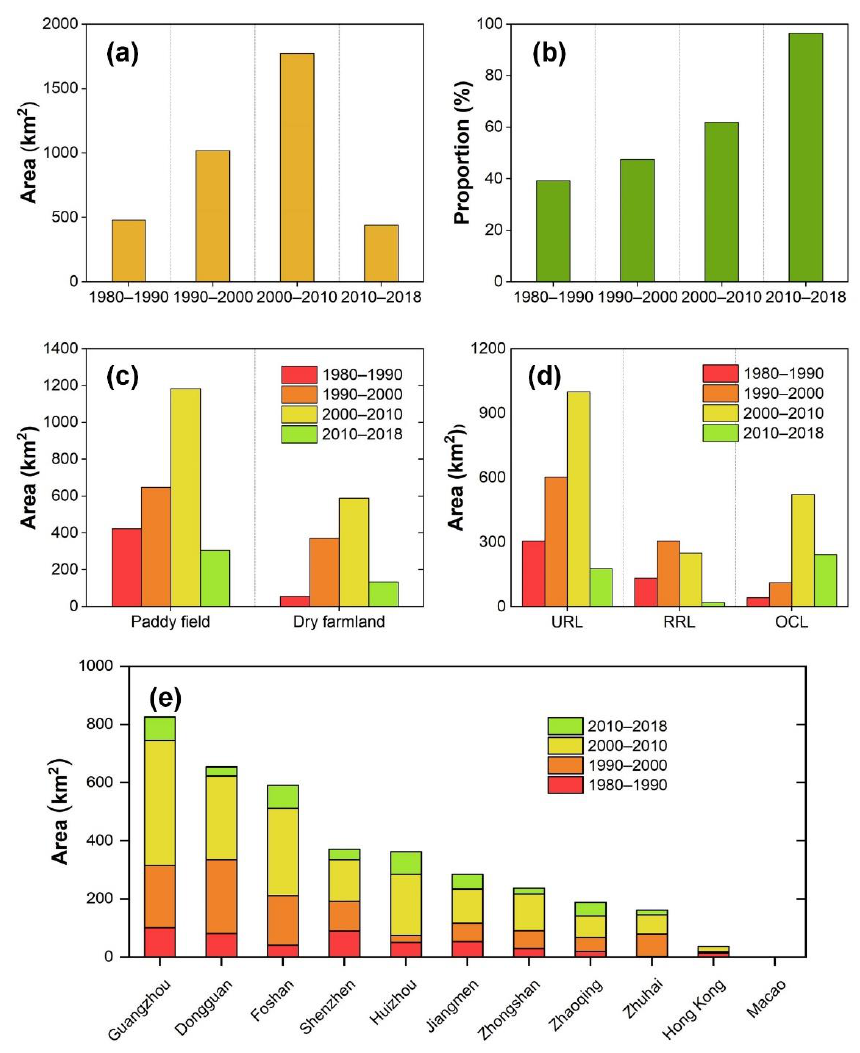
Figure 5. Farmland loss due to urbanization in the GBA during the four study periods: ( a ) is the area of farmland converted to construction land in the GBA during the four study periods; ( b ) presents the percentage of the area of farmland converted to construction land in the total area of farmland loss in the GBA during the four study periods; ( c ) shows the variation among the losses of different farmland categories due to urbanization in the GBA during the four study periods; ( d ) is the variations in the area of farmland converted into different categories of construction land in the GBA during the four study periods; and ( e ) shows the area of farmland converted to construction land in the 11 cities during the four study periods. URL: urban residential land; RRL: rural residential land; OCL: other construction land.